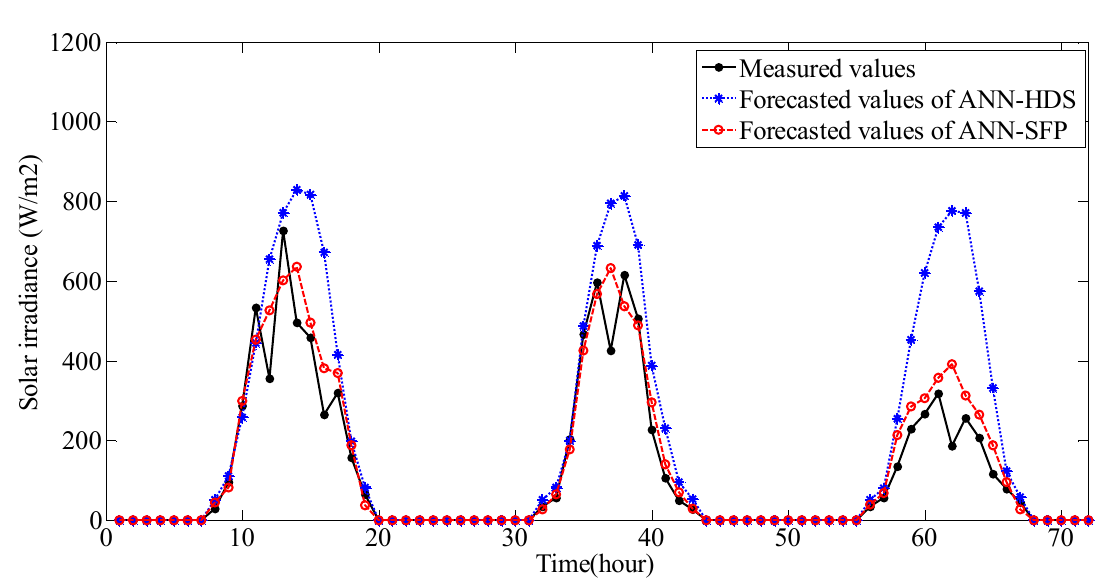
Figure 6. Forecasted and measured values for cloudy